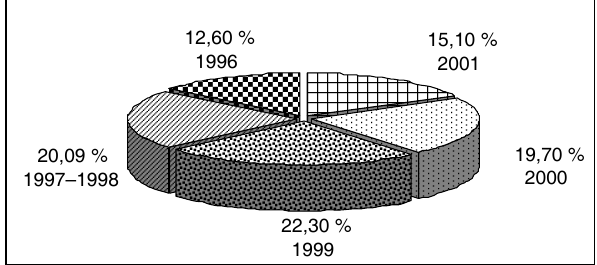
Fig 1. Labour forces employed in the Palestinian con- struction industry (PASSIA,